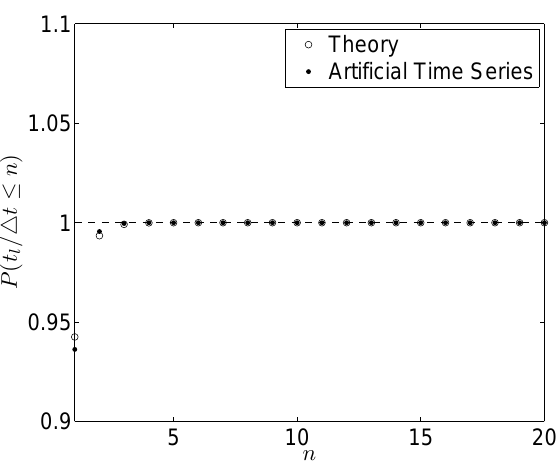
Fig. 10. Duration distribution for the independent time series. Cir- cles are equation (25) and dots are computed from artificial time series shown in Figure 7.